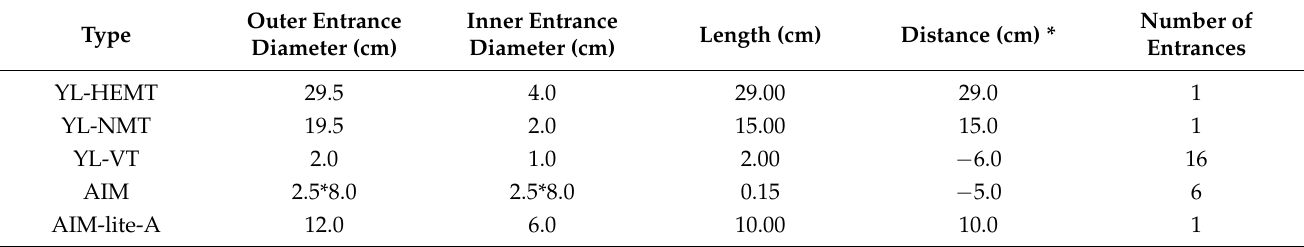
Table 1. Morphological parameters of insect inlet devices of five types of traps.